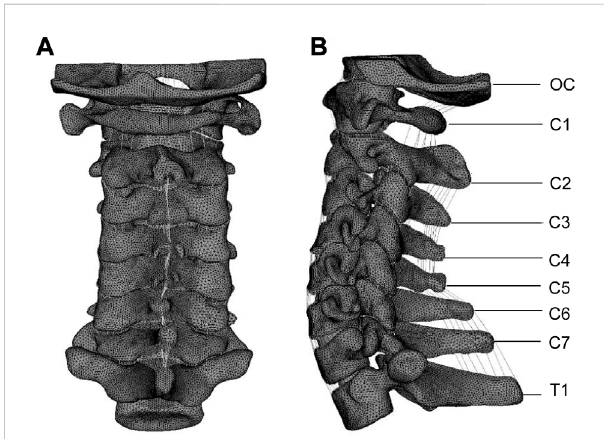
FIGURE 1 Posterior (A) and lateral (B) views of the fi nite element model of the whole cervical vertebra (OC-T1). Reproduced from the ref. (Xie et al., 2021), Copyright (2021), with permission from